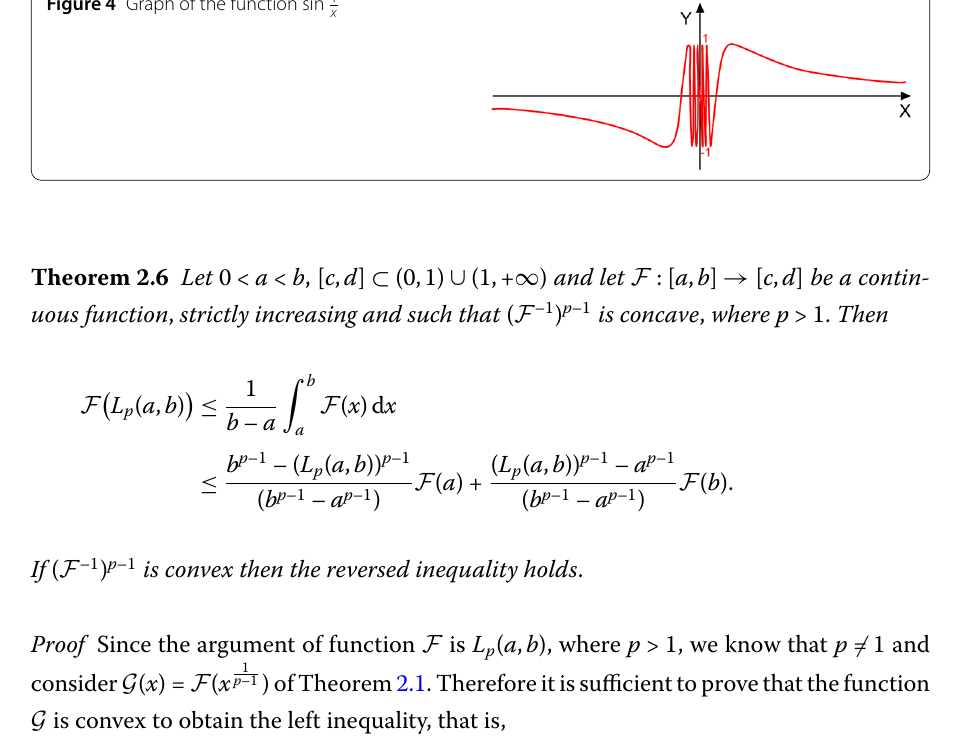
Figure 4 Graph of the function sin 1